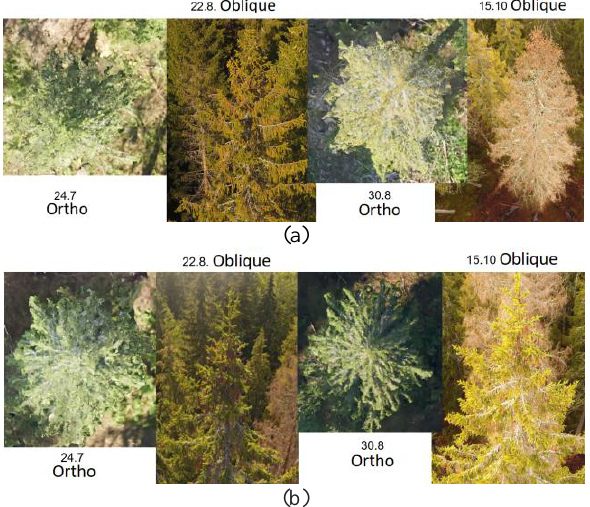
Figure. 3. Visual examination of (a) a dying and (b) a stable spruce from different views on four dates July 24, August 28, August 30 and October 15.